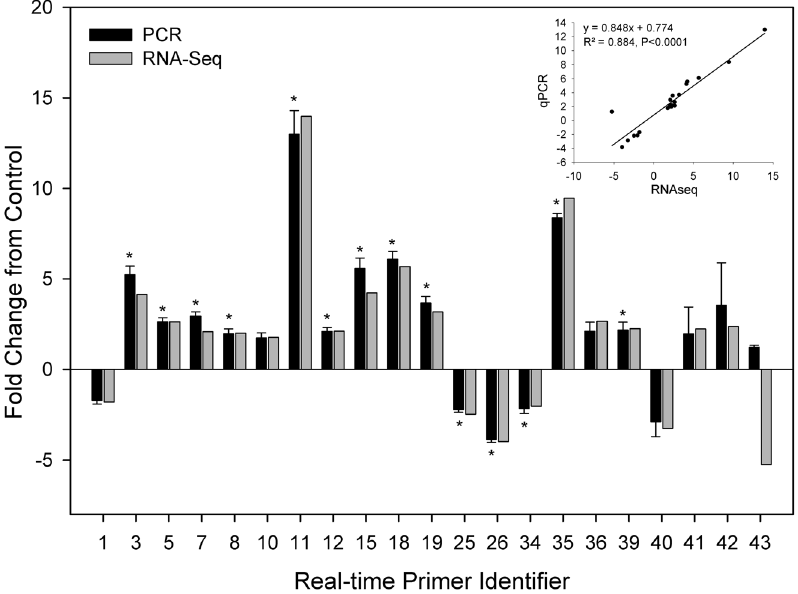
Figure 1. Comparison of transcript expression in terms of fold change as measured by RNA-seq and qPCR. The transcript expression fold changes measured by RNA-seq and qPCR are indicated by dark grey and light grey columns, respectively. Asterisks on the qPCR values indicate significant differences between control and stressed fish at p , 0.05. doi:10.1371/journal.pone.0088492.g001 PLOS ONE |